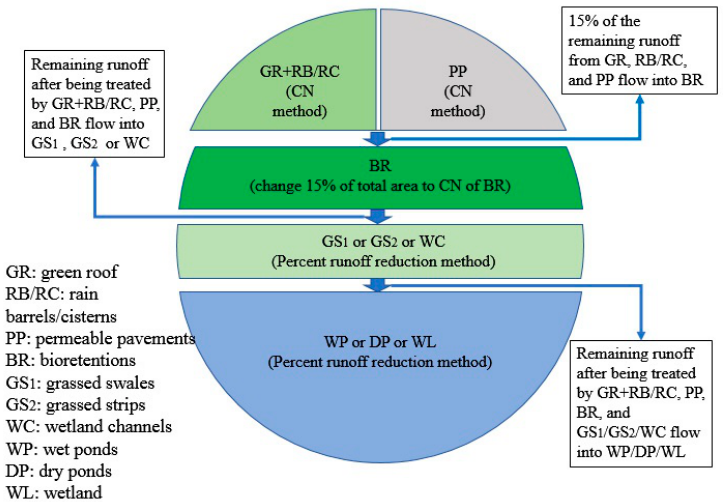
Figure 2. Assessment process of runoff control capacity of green infrastructure (GI) practices in a single hydrologic response unit (HRU).